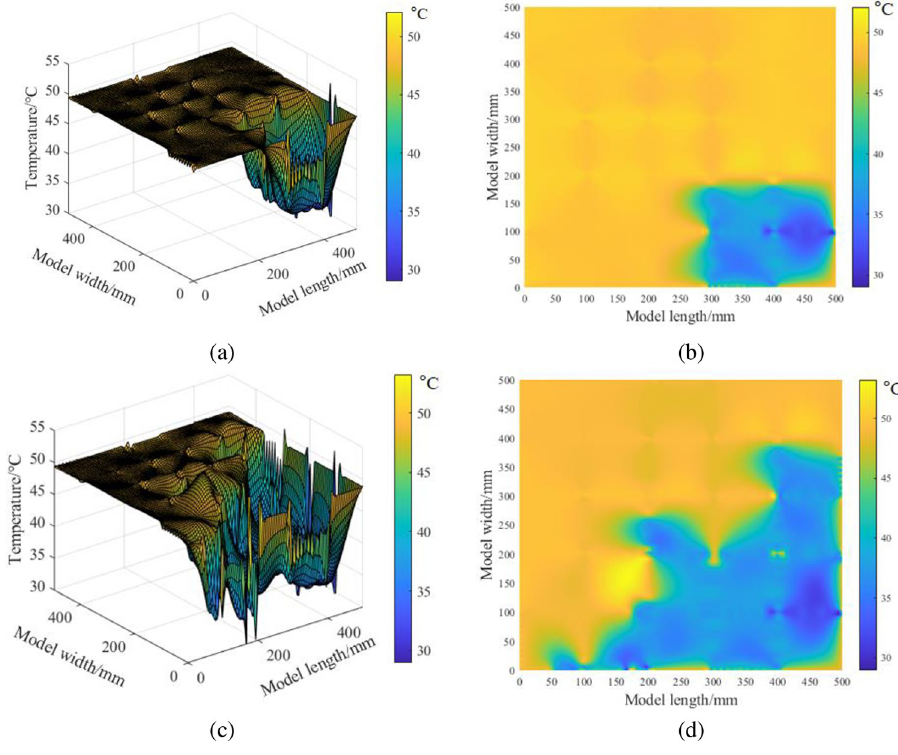
Fig 10. Grouting diffusion